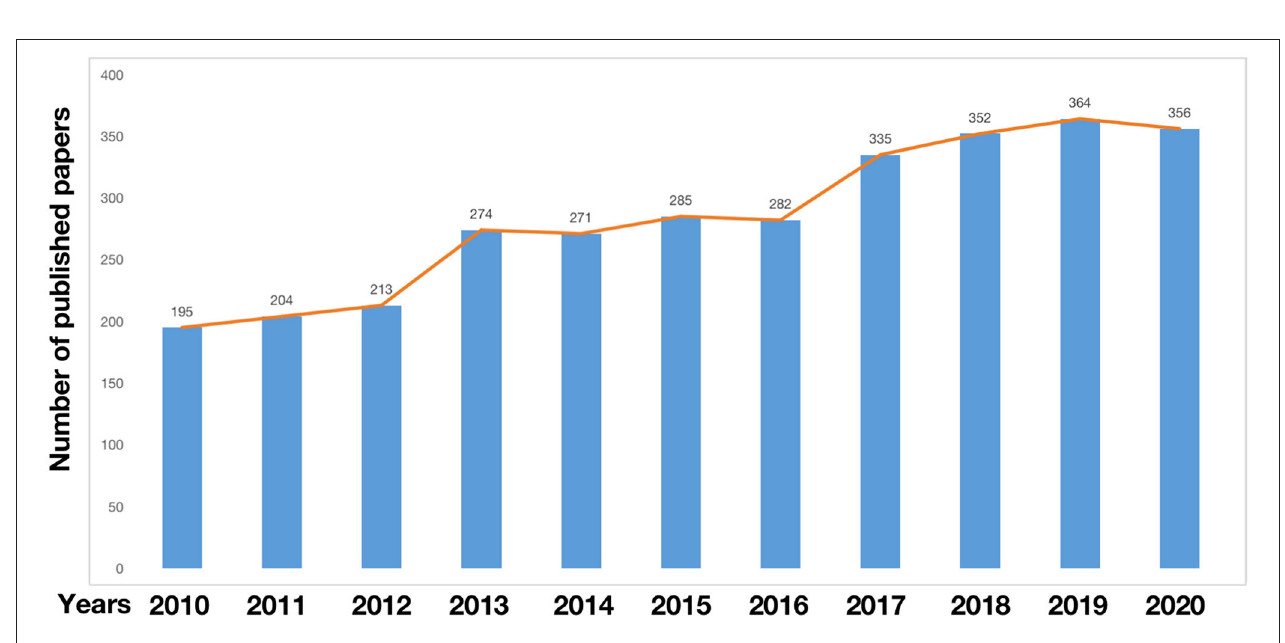
FIGURE 1 | Flowchart for including and excluding literature studies.